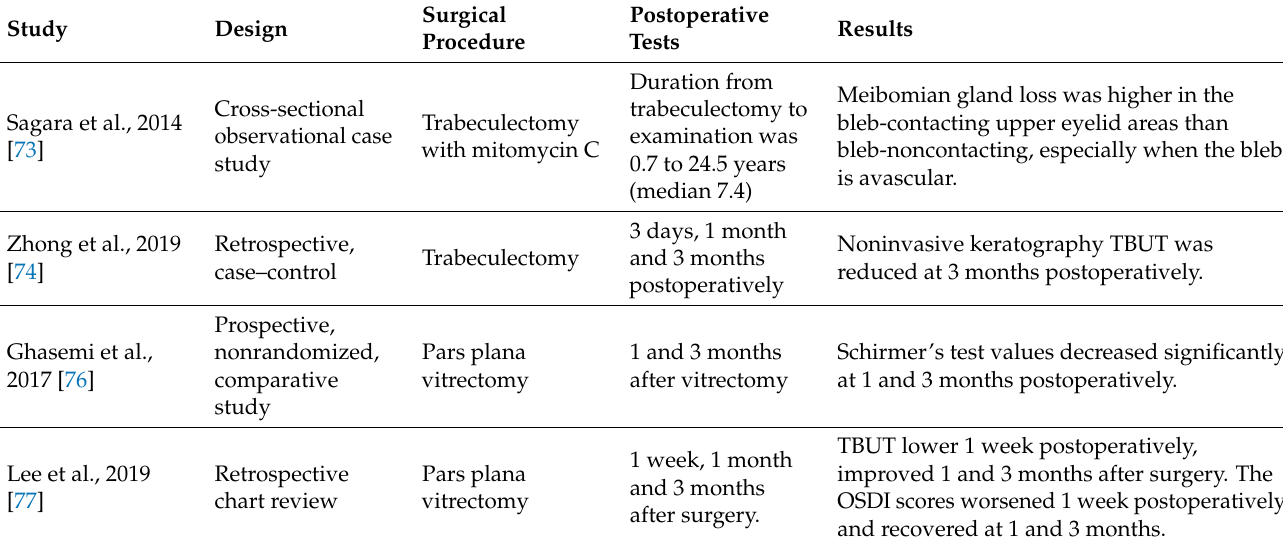
Table 3. Ocular surface dysfunction after trabeculectomy and